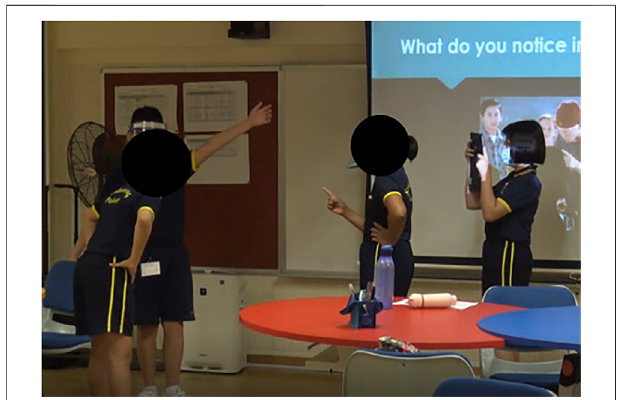
FIGURE 5 | Students ’ taking a Freeze